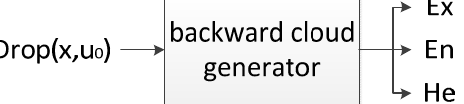
Figure 8. Flow chart of backward cloud generator.